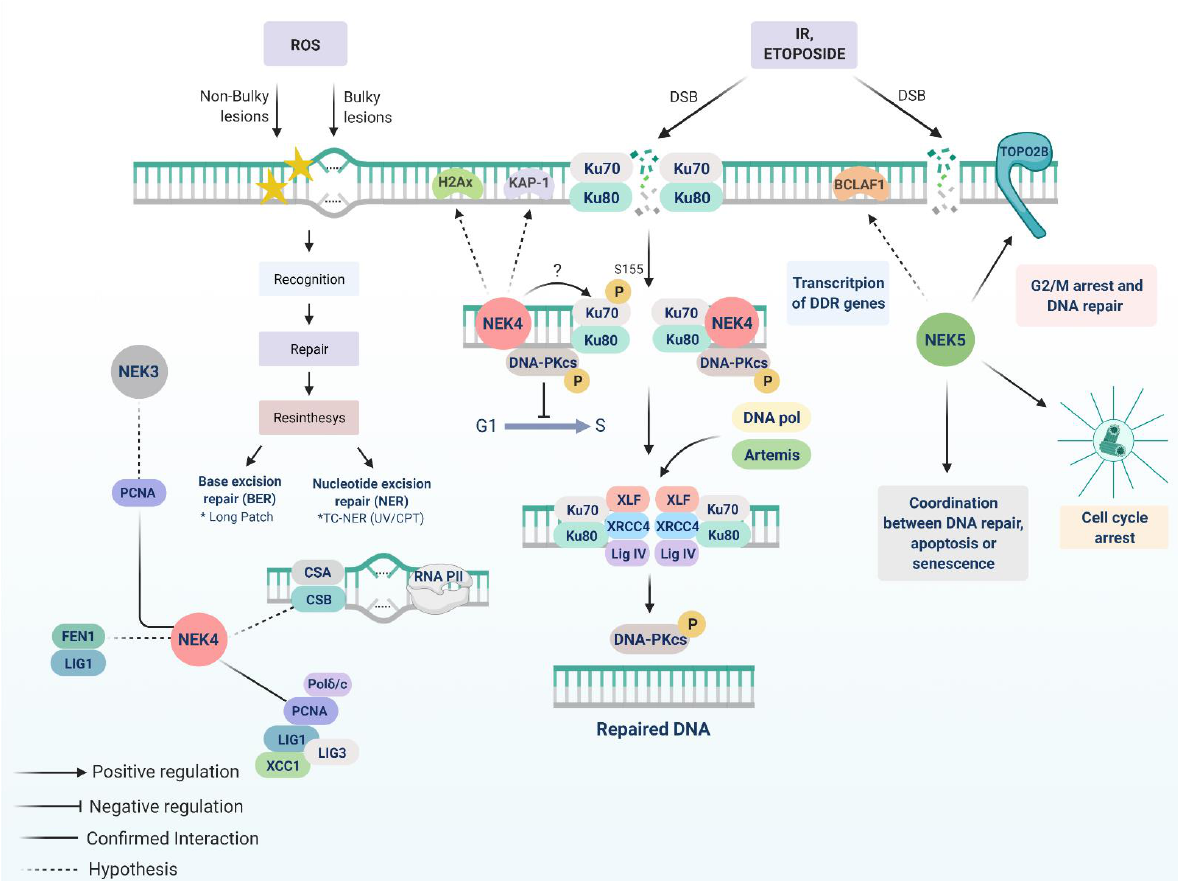
Figure 2. NEK3, NEK4, and NEK5 roles in DDR. The interaction of NEK3 and PCNA is a possible link between NEK3 and DDR. NEK4 interacts with the DNA-PK complex and is important for efficient DNA-PKcs recruitment to DNA damage foci, as well as the activation of pathways essential to induce cell cycle arrest after DSBs with IR or etoposide. We propose that NEK4 acts very early in DNA break recognition, phosphorylating Ku70 (possibly at S155 residue) and stabilizing the DNA-PK complex. Also, NEK4 possibly interacts with other NHEJ-related proteins, such as H2AX, and KAP-1, and PCNA, and FEN1. The interaction between NEK5 and topoisomerase IIβ might be related to cell cycle halting due to DNA damage, as this interaction increases during the first stage of DDR. NEK5-depleted cells overcome the G2/M checkpoint upon DNA damage, indicating that NEK5 is required for an appropriate DDR.